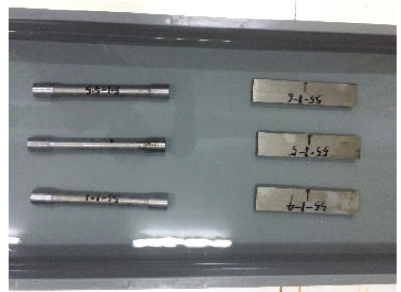
Figure 2: Specimens immersed in soil